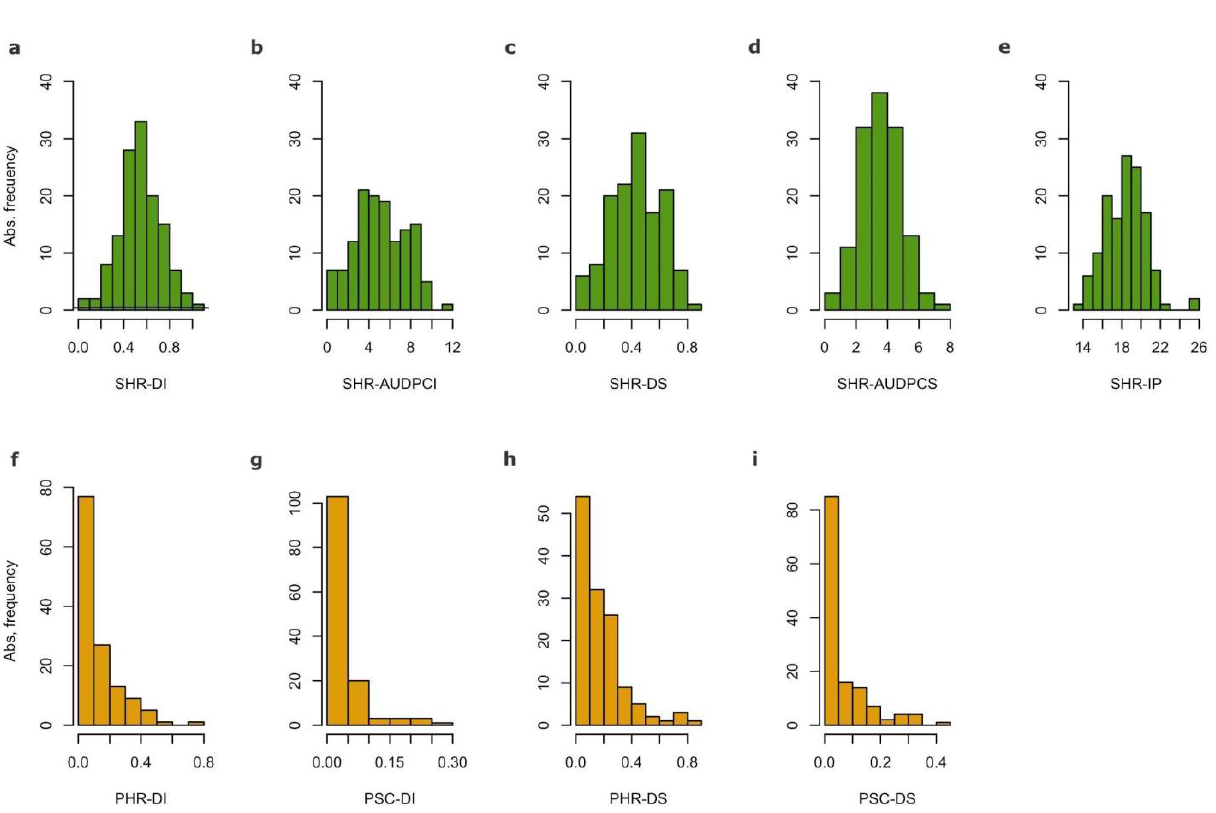
Figure 1. Histograms of standardized adjusted means. Upper panel: ( a ) Sclerotinia head rot (SHR) disease incidence (DI); ( b ) SHR area under the disease curve for DI (AUDPCI); ( c ) SHR disease severity (DS); ( d ) SHR AUDPC for DS (AUDPCS); ( e ) SHR incubation period (IP). Lower panel: ( f ) Phomopsis head rot (PHR) DI; ( g ) PHR DS; ( h ) Phomopsis stem canker (PSC) DI; ( i ) PSC DS.